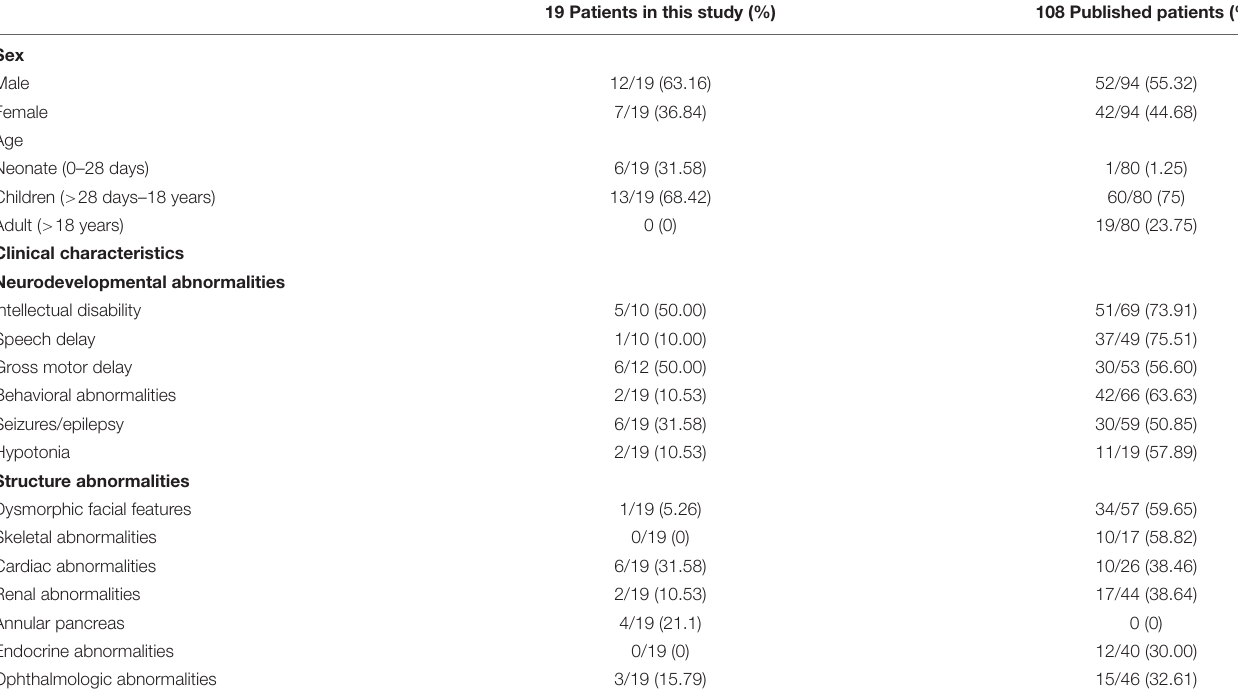
TABLE 1 | Summarized characteristics of patients with 17q12 duplication in the present study and published studies. 19 Patients in this study (%) 108 Published patients